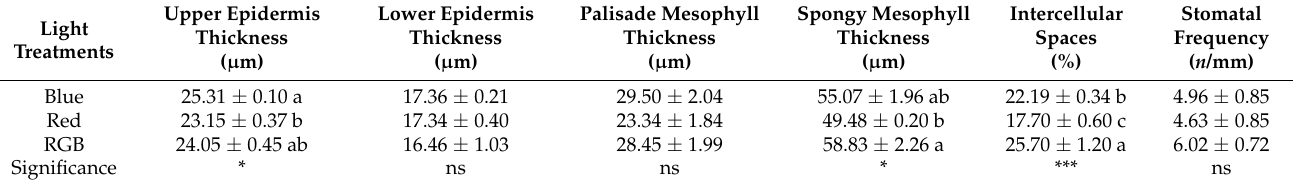
Table 2. Anatomical measurements of parsley microgreens with reference to the different light treatments (red, blue and